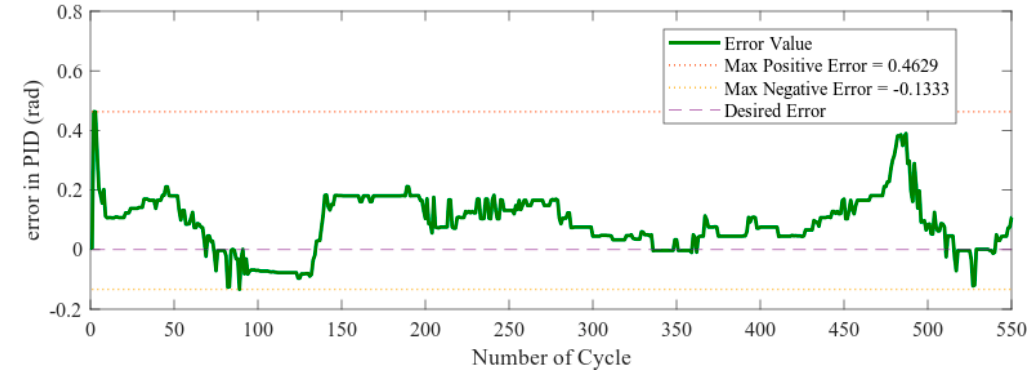
Figure 15. Error term for proportional-integral-differential (PID) control.